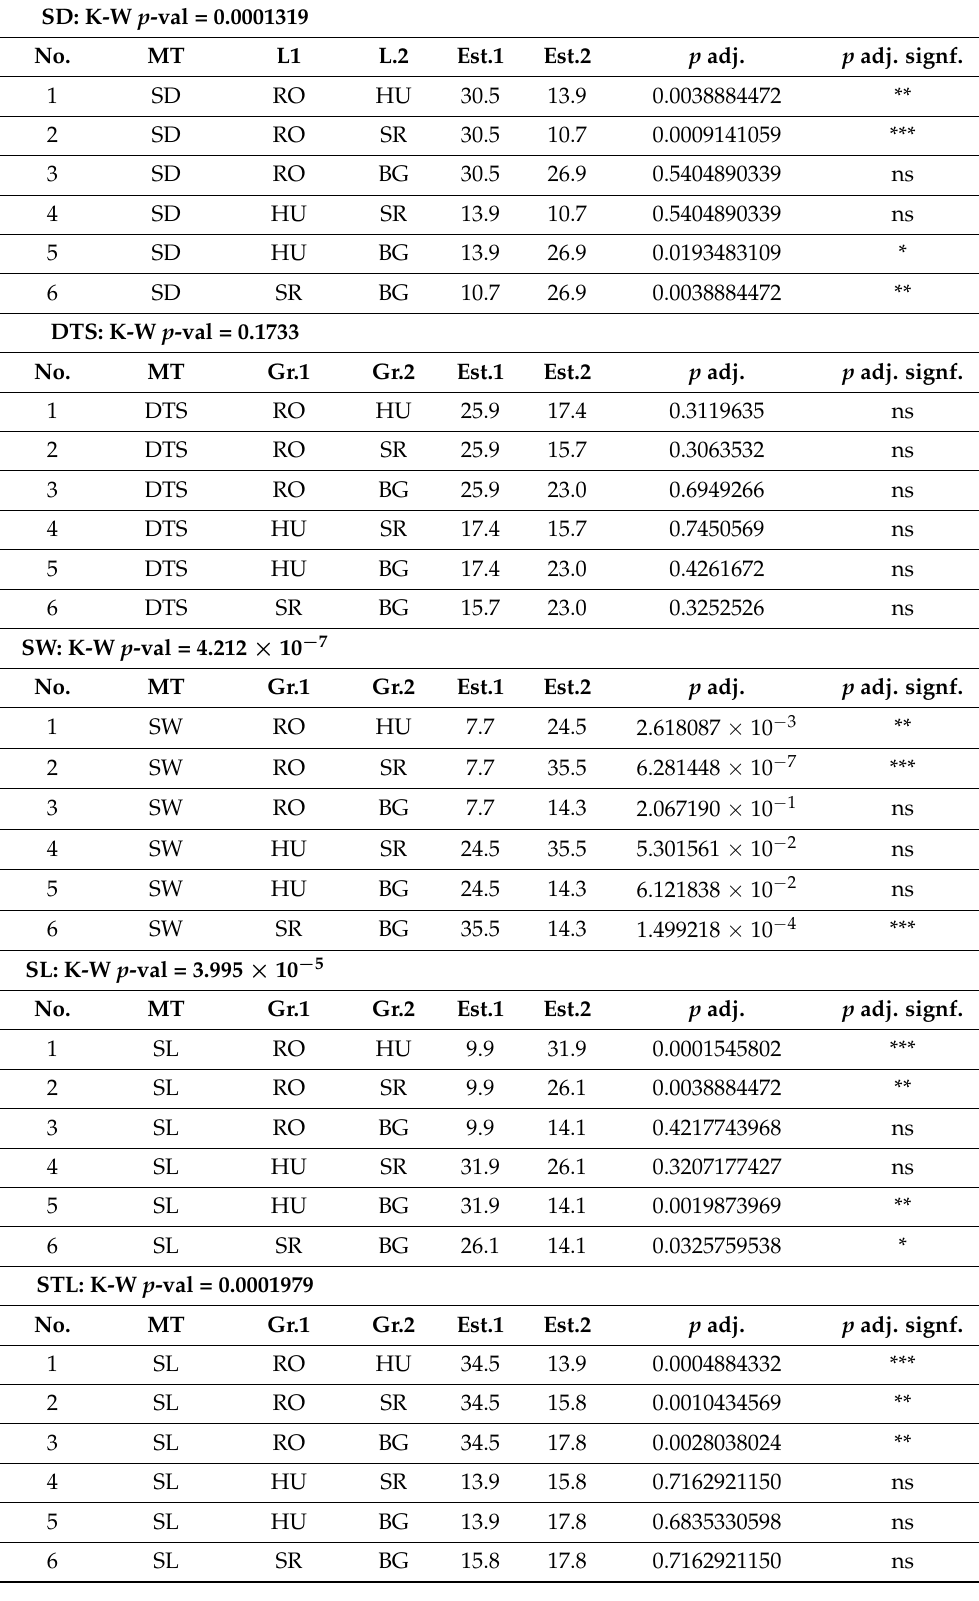
Table 3. Kruskal-Wallis p -values are depicted for each MT, as well as adjusted p -values for each of the six pair-wise comparisons (Location L1 vs. Location L2) performed with a Dunn’s test. Significance was considered at a p -value threshold of